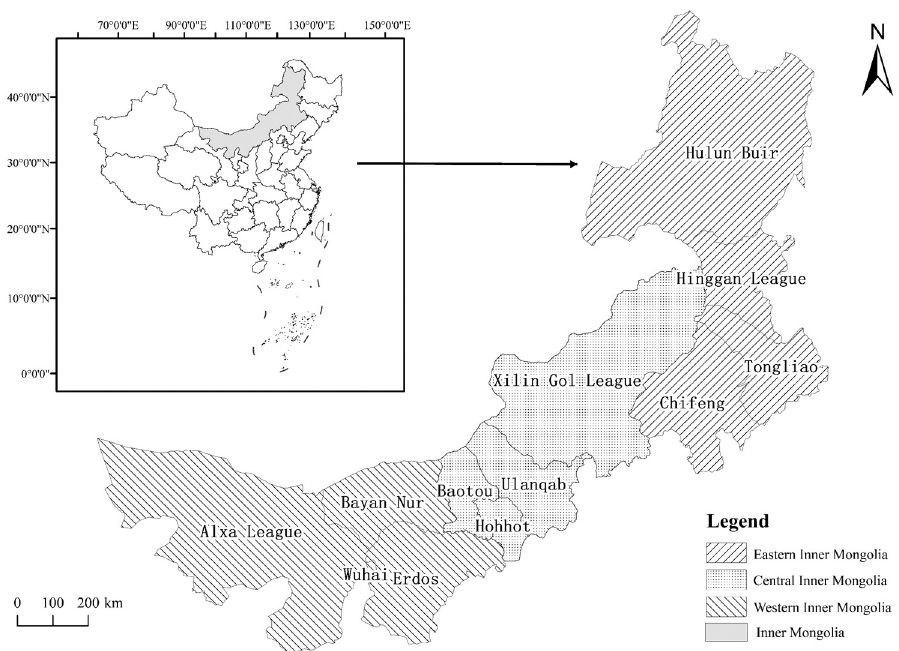
Figure 1. Regional map of the Eastern, Central, and Western Inner Mongolia.